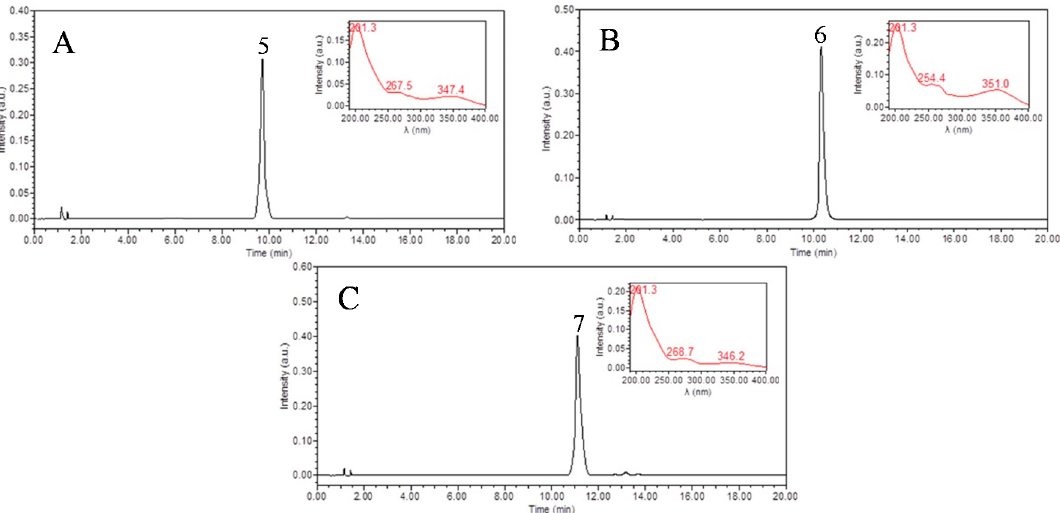
Figure 4. Chromatograms of pre-HPLC fractions. ( A : vitexin, 5 in Figure 3A; B : hyperoside, 6 in Figure 3A; C : isoquercitrin, 7 in Figure 3A).